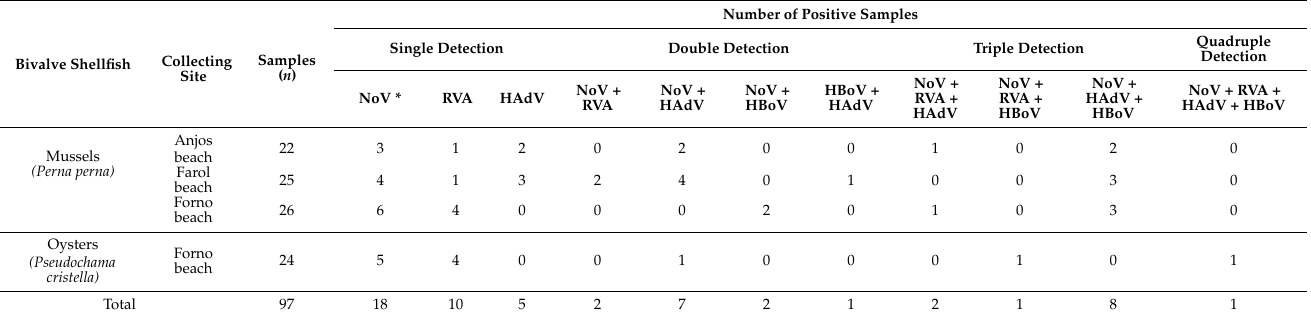
Table 2. Single and multiple detections of enteric viruses by bivalve species and collection